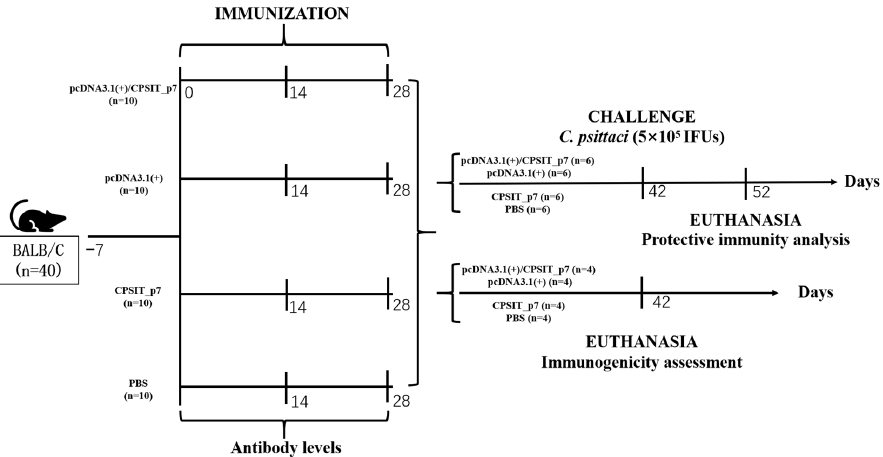
Figure 7. The timeline of immunization and overall in vivo work through the terminal point on day 52.